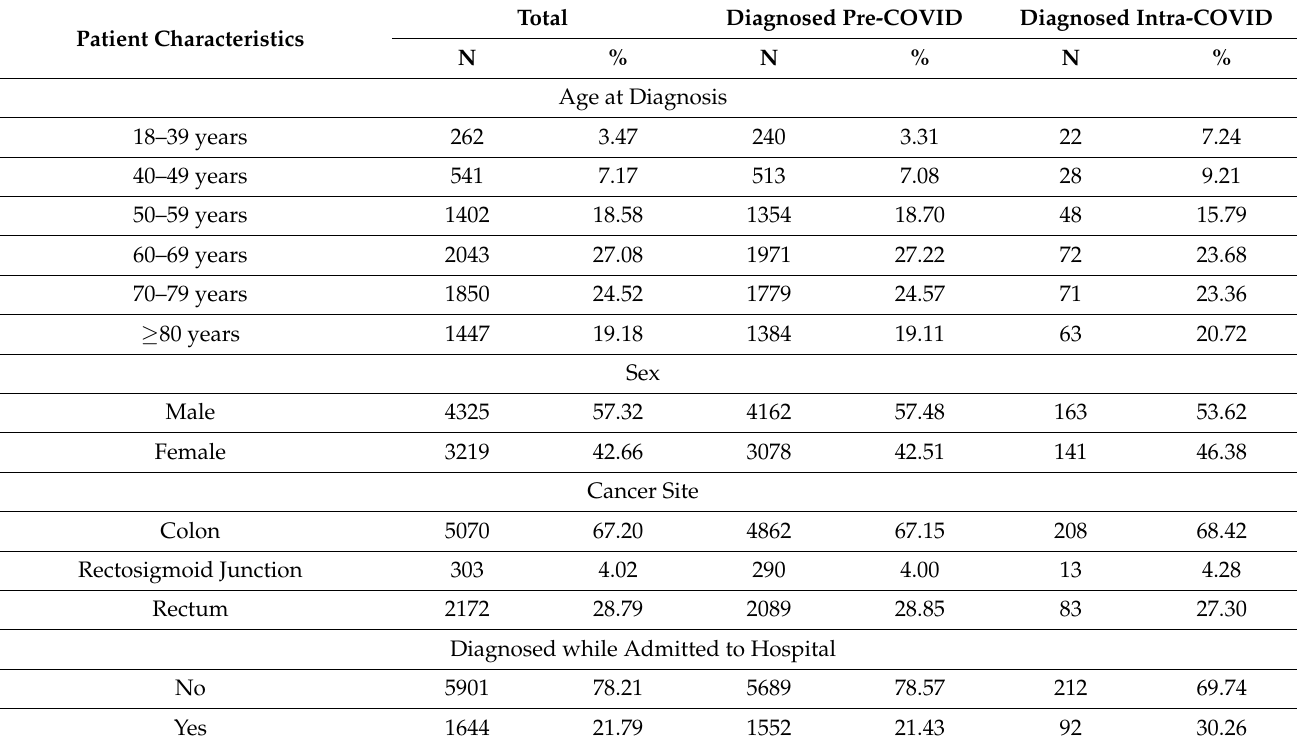
Table 1. Frequency and distribution of patient characteristics and tests/procedures within 1 year prior to diagnosis among 7545 patients diagnosed with colorectal cancer between 1 January 2016 and 1 July 2020 in Alberta, Canada.